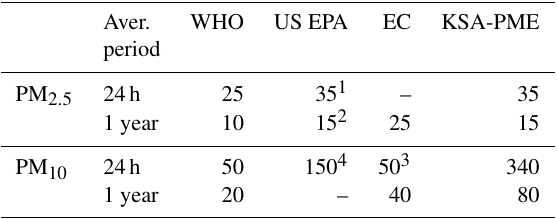
Table 1. Air quality regulations for PM 2 . 5 and PM 10 prescribed by the WHO, US EPA, EC, and KSA-PME (µgm − 3 ). Aver. WHO US EPA EC KSA-PME